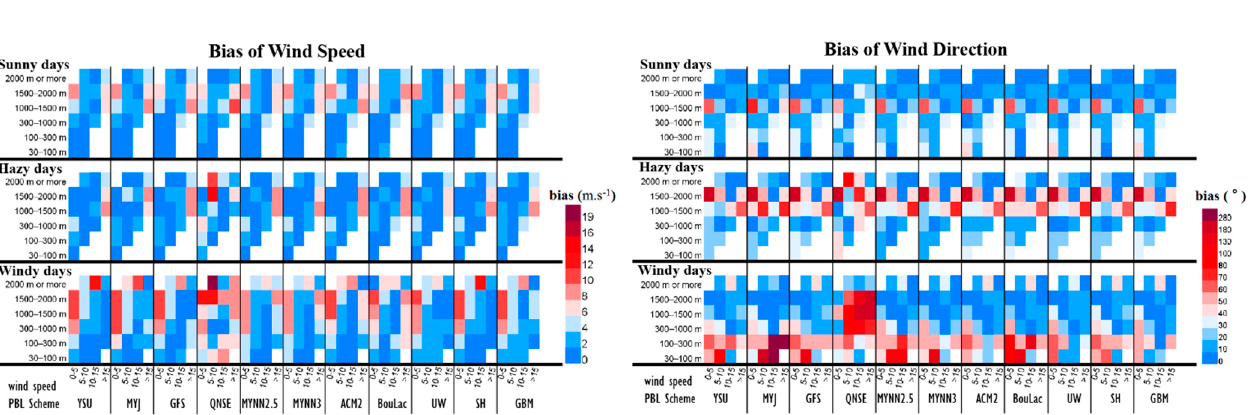
Figure 6. The model biases in wind speed (left, bias less than 2 m · s − 1 ) and wind direction (right, bias less than 20 ◦ ) depending on the PBL schemes, the layer heights and the wind speeds on sunny, haze and windy days.